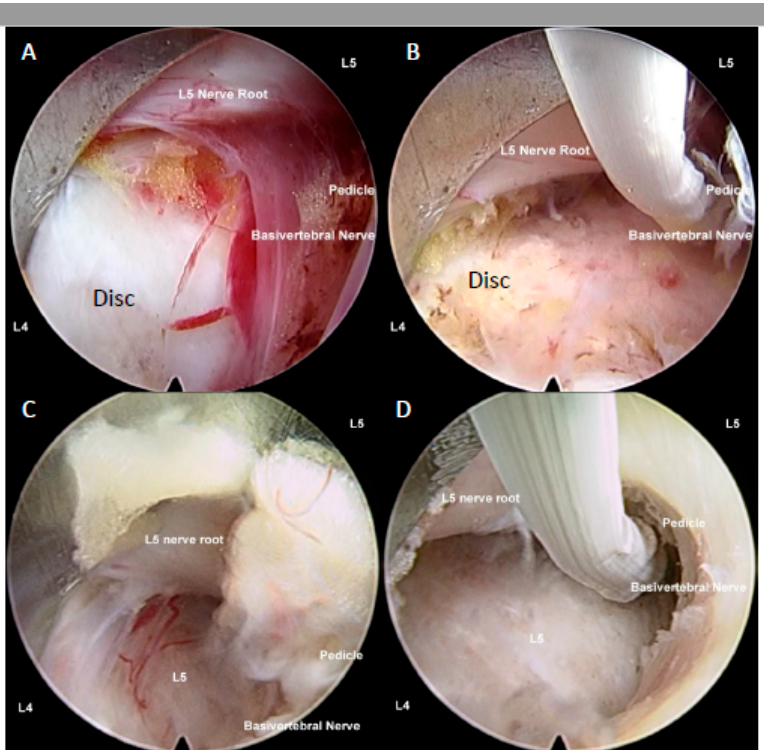
Figure 6. ( A ) Uniportal interlaminar endoscopic approach to disc showing the relationship of the lumbar five (L5) traversing nerve root which is retracted away by the working channel, exposing the disc of L4/5, the basivertebral nerve is located above pedicle of left L5, there is grade 3 neovascularization and inflammatory granulation tissue with adhesion around the basivertebral nerve region. In most circumstances, the basivertebral nerve is too fine to be seen by endoscopic vision. ( B ) Same region in the same patient after radiofrequency was applied to shrink the degenerative disc, and to ablate the pathological neovascularization with underlying inflammatory tissues and the basivertebral nerve, the typical response is twitching of the buttock when the correct location of the basivertebral nerve is ablated. ( C ) Another patient with similar steps in retraction of traversing nerve root and exposing neovascularized tissue and the location of the basivertebral nerve. ( D ) Radiofrequency ablation applied to neovascularized tissue, disc and basivertebral